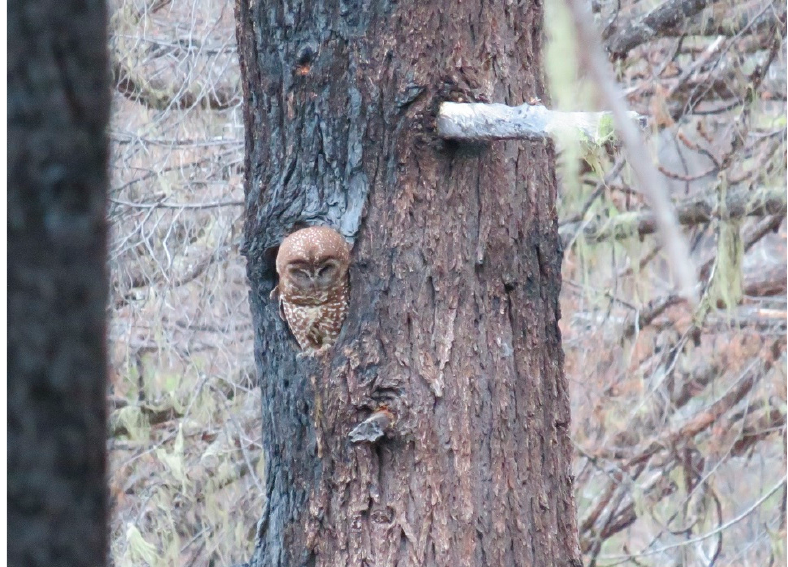
Figure 1. Northern Spotted Owl (NSO) nest site with young in a severely burned undisclosed location (photograph Courtesy of Maya Khosla with permission).